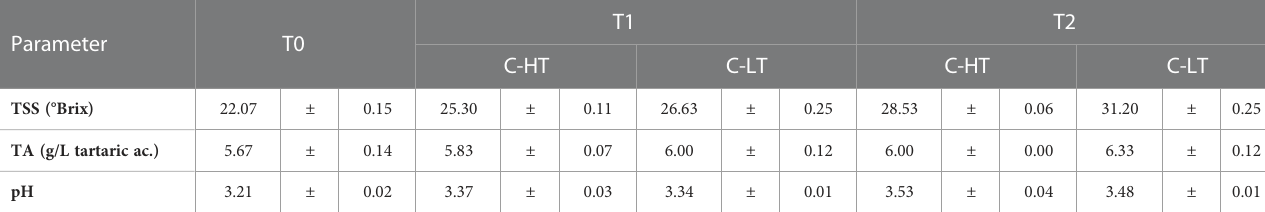
TABLE 1 Total soluble solids (TSS), total acidity (TA) and pH measured in grapes dehydrated in the C-HT and C-LT rooms at sampling time points (T0, T1 and T2).